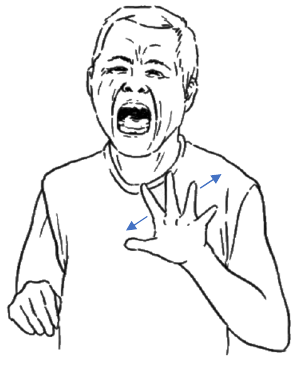
Figure 1. Basic manual clause negator in Kata Kolok including a negative facial expression with furrowed brows and pulled-down corners of the mouth, as described by Marsaja (2008).; Adapted with permission from de Vos (2012); copyright 2012 Max Planck Institute for Psycholinguistics.